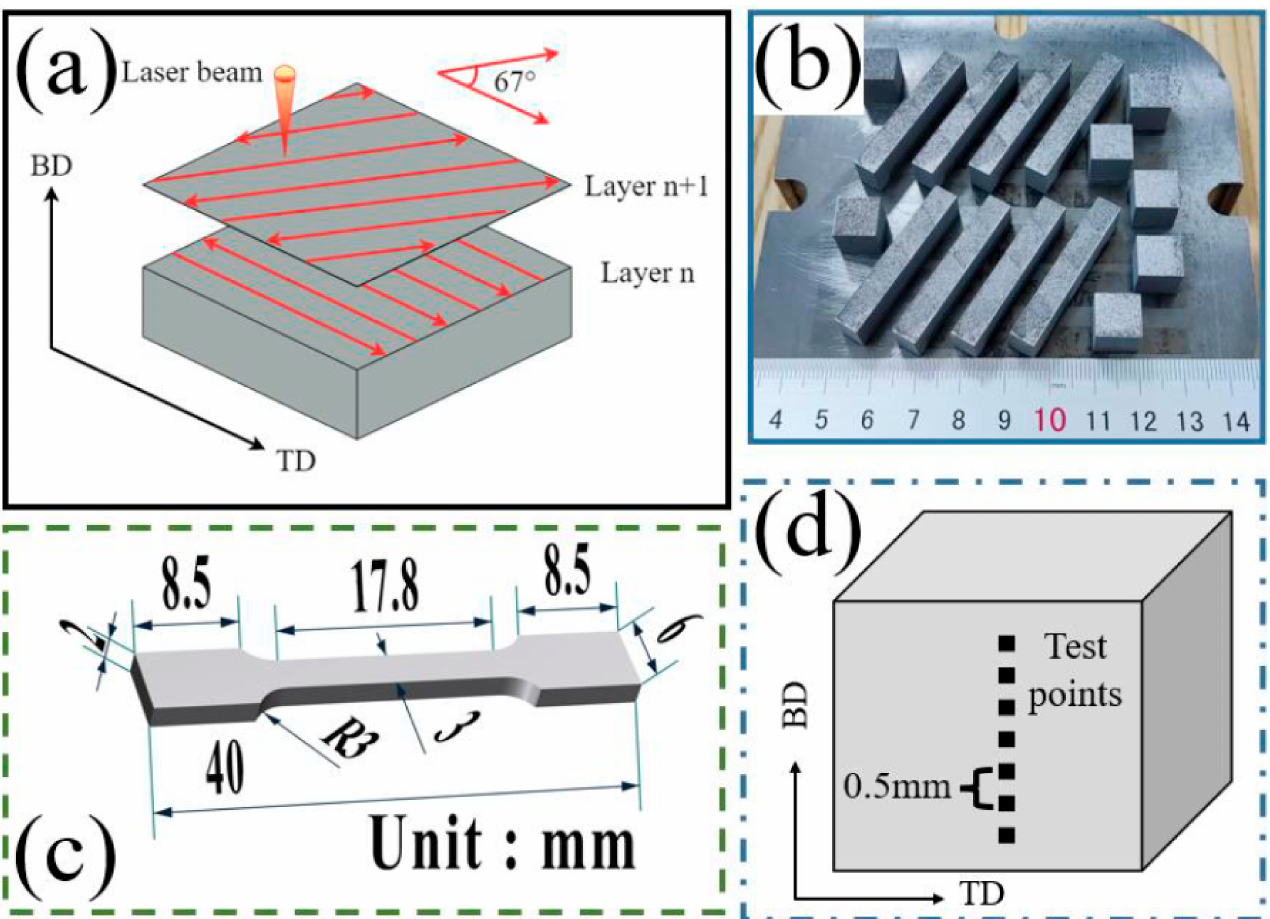
Figure 2. ( a ) The scan strategy schematic diagram of the manufacturing process, ( b ) The tantalum parts manufactured by SLM, ( c ) The schematic diagram of the sample size for tensile test, and ( d ) the schematic diagram of the hardness test positions. (Note: BD is the building direction, while TD is the transverse